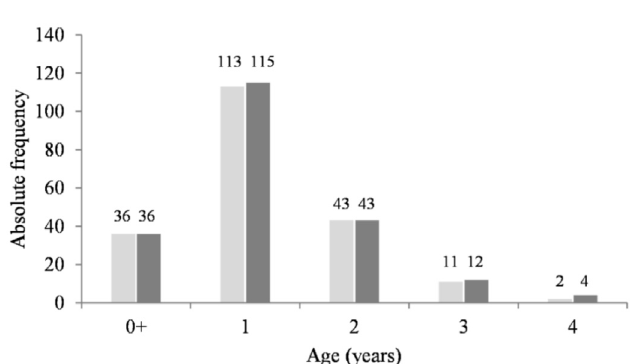
Fig. 6. Age composition of females ( ) and males ( ) of Auxis thazard landed in the Southeastern Brazil between March 2018 and February 2019. Numbers above bars correspond to number of aged fi